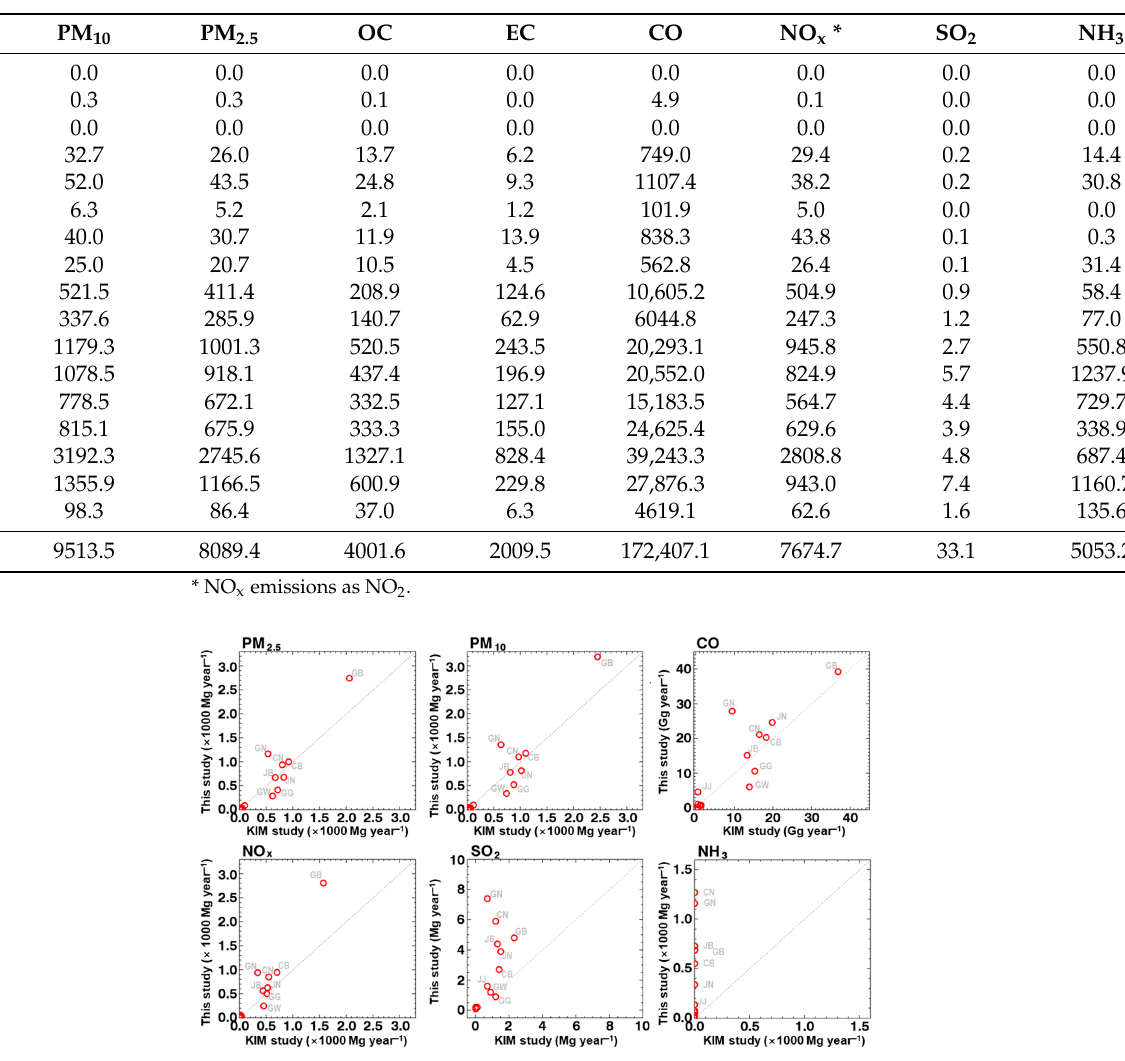
Figure 5. Scatter plots between KIM and our estimates for annual CRB emissions of 17 provinces.